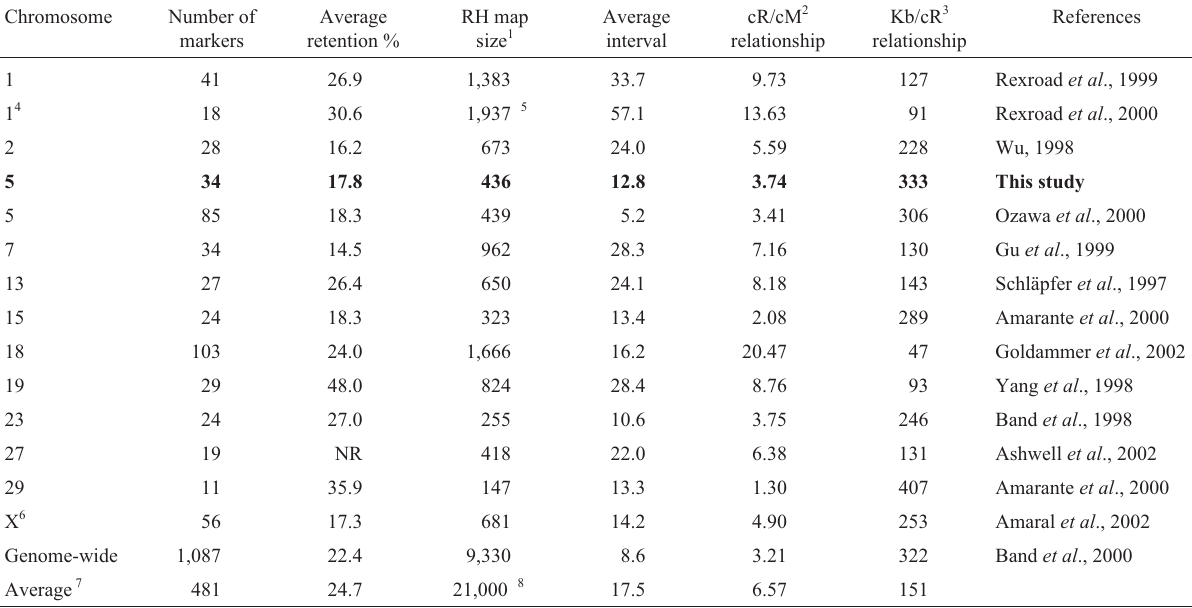
Table 4 - Comparison of RH maps from several bovine chromosomes, constructed using the RHA panel.